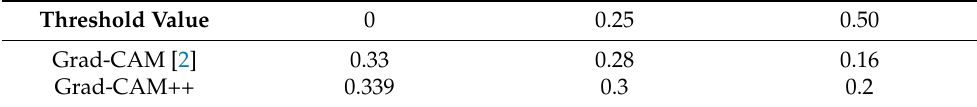
Table 2. Intersection over Union (IoU) results for object localization.